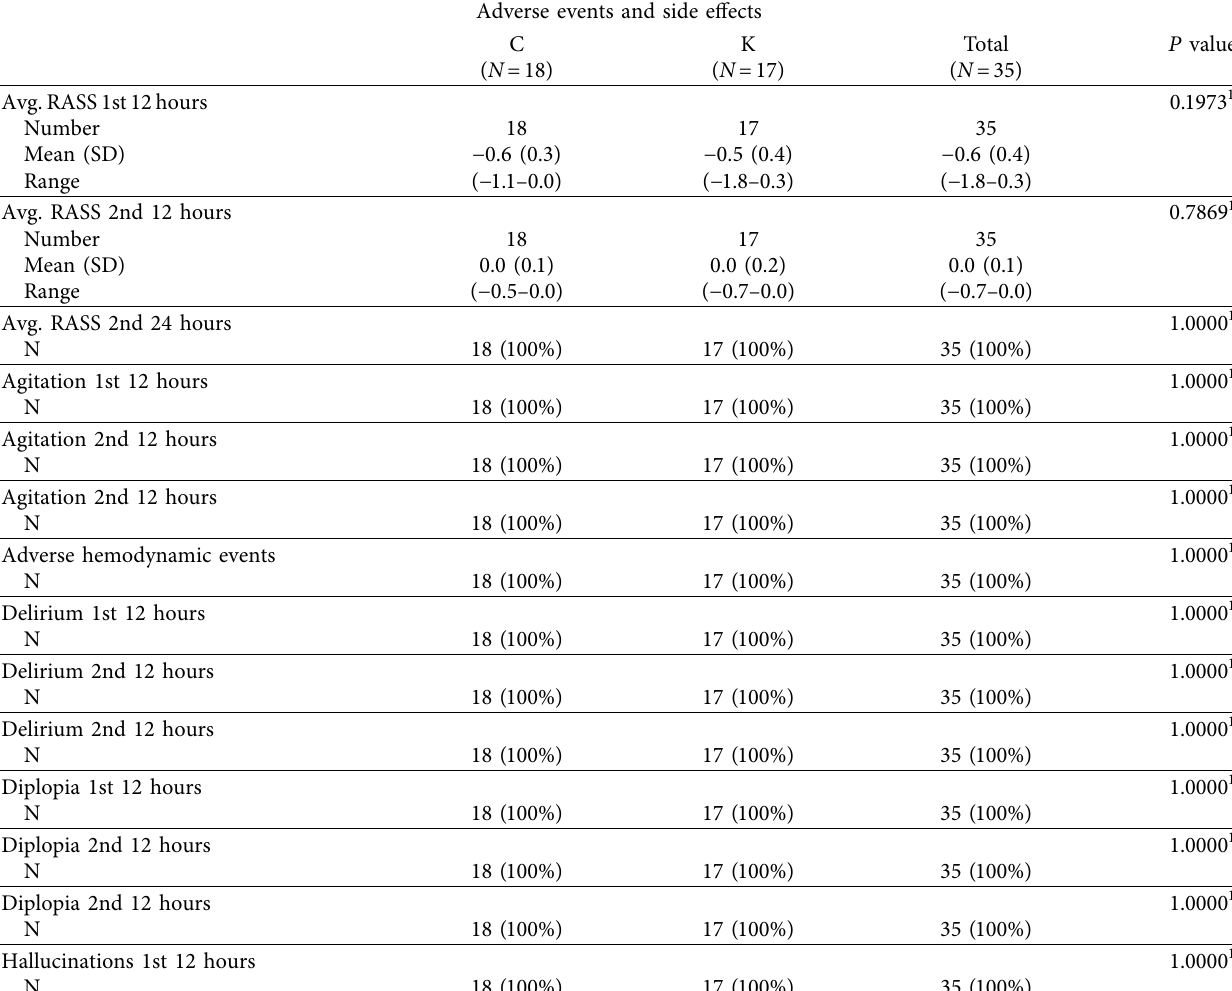
Table 5: Data on the adverse events and side effects that occurred.